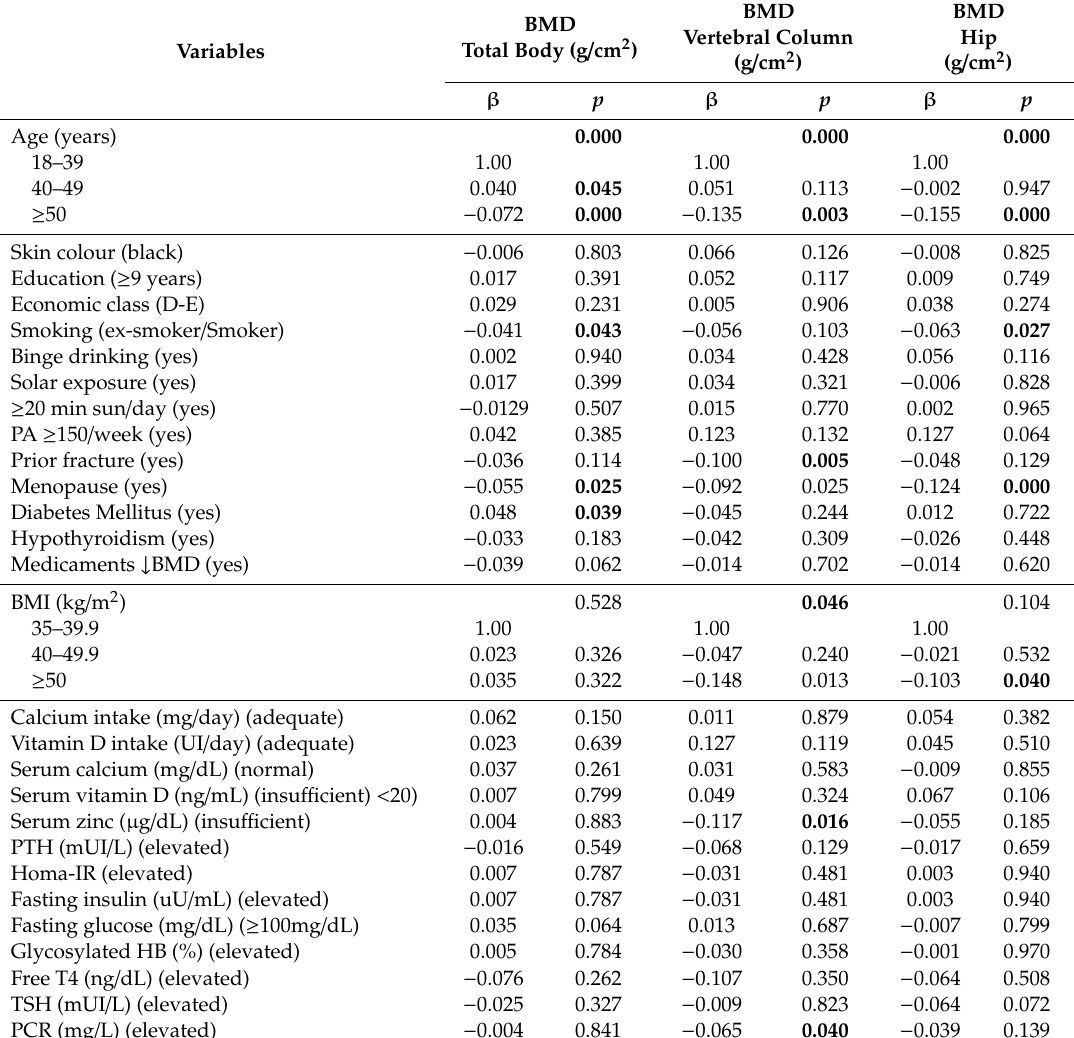
Table 4. Simple linear regression of three bone mineral density sites and their relationship with sociodemographic variables, health conditions, nutritional indicators and biochemical tests in severely obese women, DieTBra Trial, 2016 ( n =